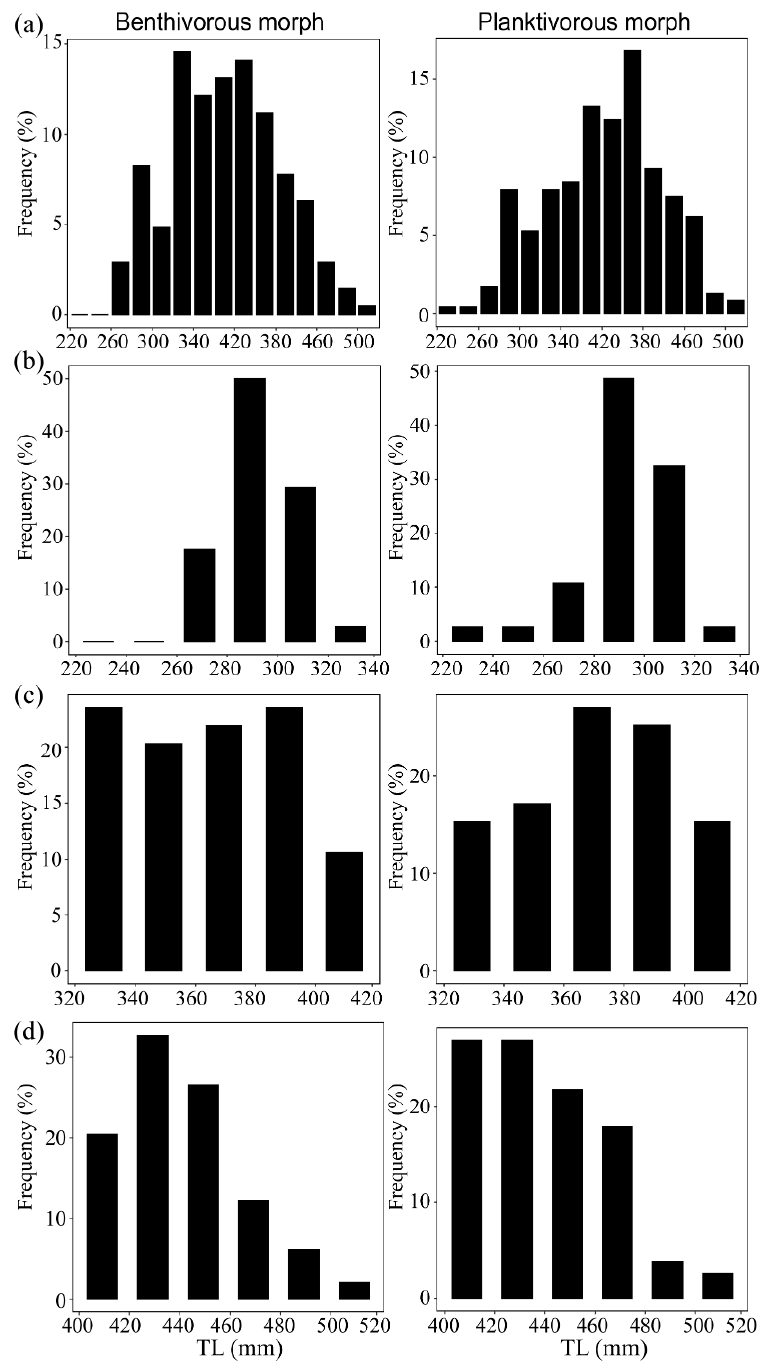
Figure 3. Length–frequency distribution (%) for benthivorous and planktivorous morphs of Schizopygopsis thermalis used in the otolith shape analysis: ( a – d ) represent the combination of all TL groups, first TL group, second TL group, and third TL group, respectively.